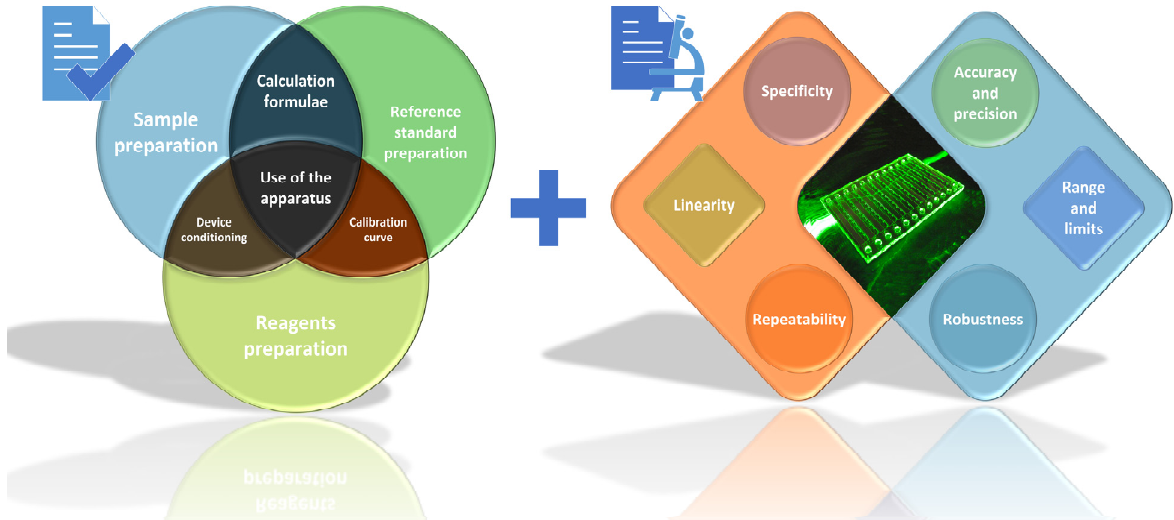
Figure 1. A microfluidic device-specific operation and industrial validation procedure elements.